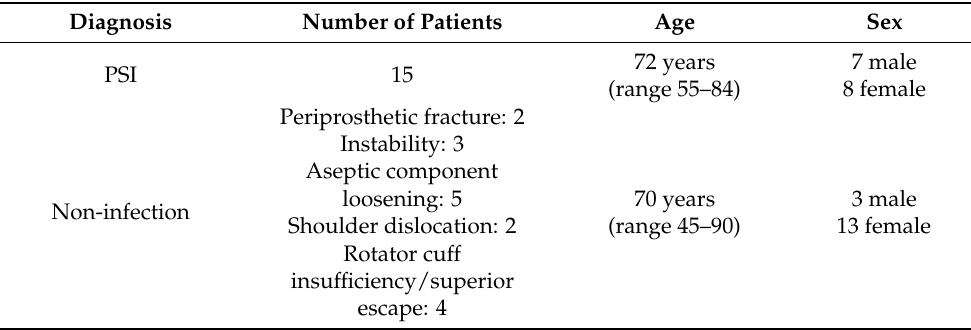
Table 1. Demographic data of the study